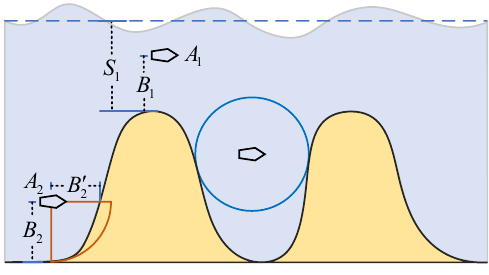
Figure 2. 2D exemplification of safety distance